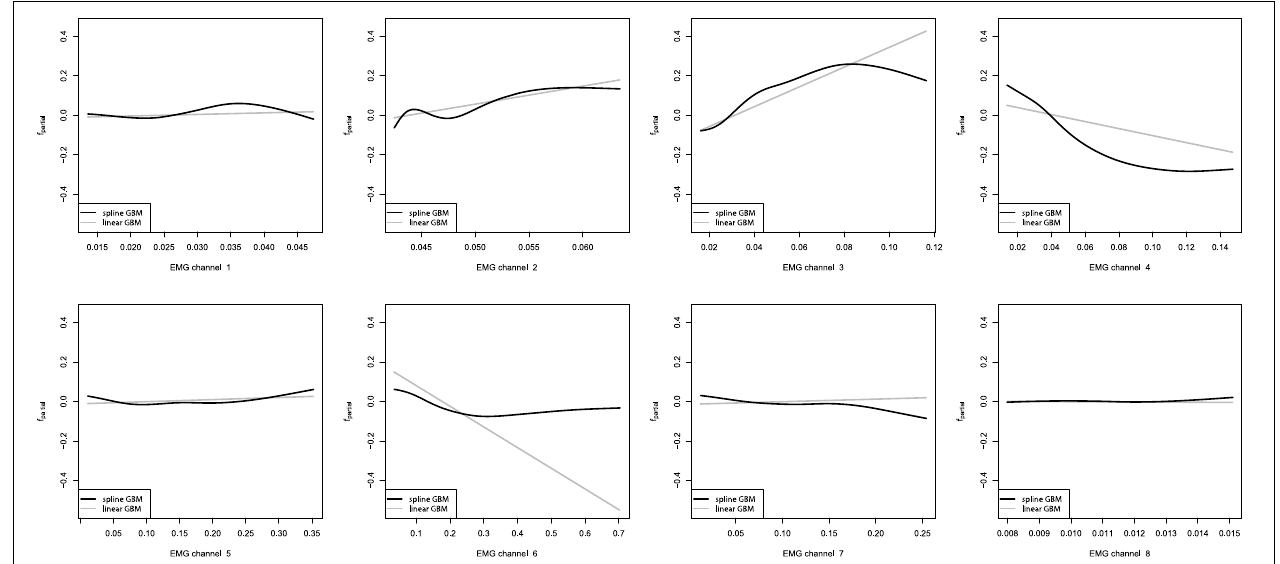
FIGURE 8 | Partial dependence plots of additive GBMs for the EMG robotic control data. The gray line corresponds to the linear GBM; the black line corresponds to the spline-based GBM.